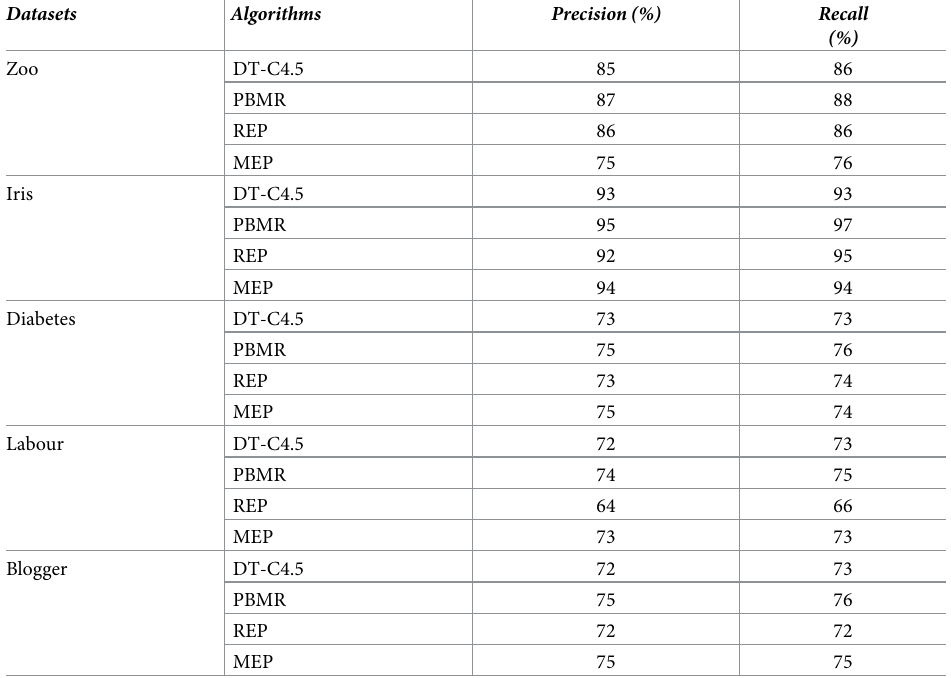
Table 7. Precision and recall scores for PBMR, REP, and MEP.